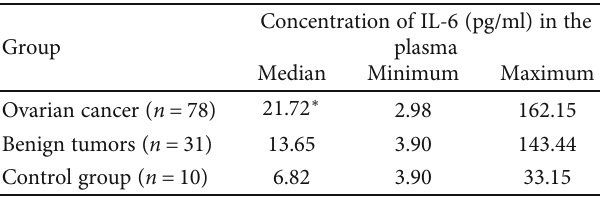
Figure 1: Flow cytometry analysis of CD45 + CD14 + cells expressing PD-L1 or PD-L2. An acquisition gate was established based on FSC and SSC that included mononuclear cells. A population P1 was drawn around MNCs (a). Next, the P1 gated events were analyzed for CD45 FITC and CD14 Pe-Cy7 staining and positive cells (CD45 + CD14 + ) were gated (region Q2) (b). The fi nal dot plots CD45 + CD14 + expressing (d) PD- L1 or (f) PD-L2 versus FMO control were established by combined gating of events using population P1 and region Q2-1 or Q2-2. The number in the upper right quadrant on the dot plots (d, e) represents the percentage of CD45 + CD14 + expressing (d) PD-L1 or (e) PD-L2. Table 2: Levels of IL-6 (pg/ml) in the plasma of patients with ovarian tumors and healthy